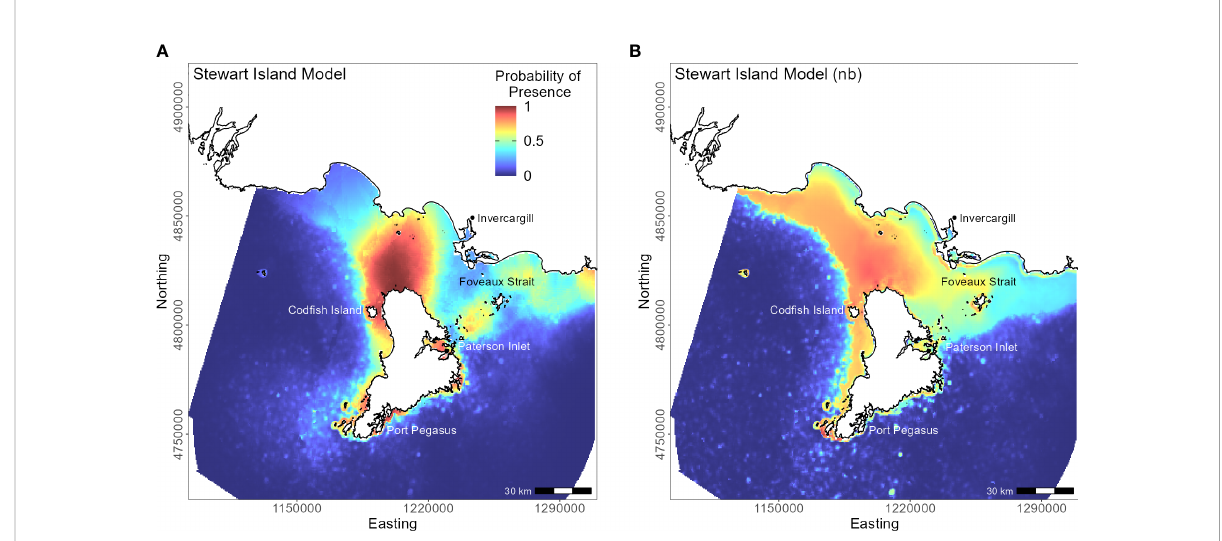
FIGURE 10 Distribution of suitable habitat for yellow-eyed penguins breeding on Stewart Island. The left map (A) depicts the predicted probability of presence (cloglog) with distance to nearest colony included a predictor variable, while the right map (B) does not include distance to colony as a predictor (nb